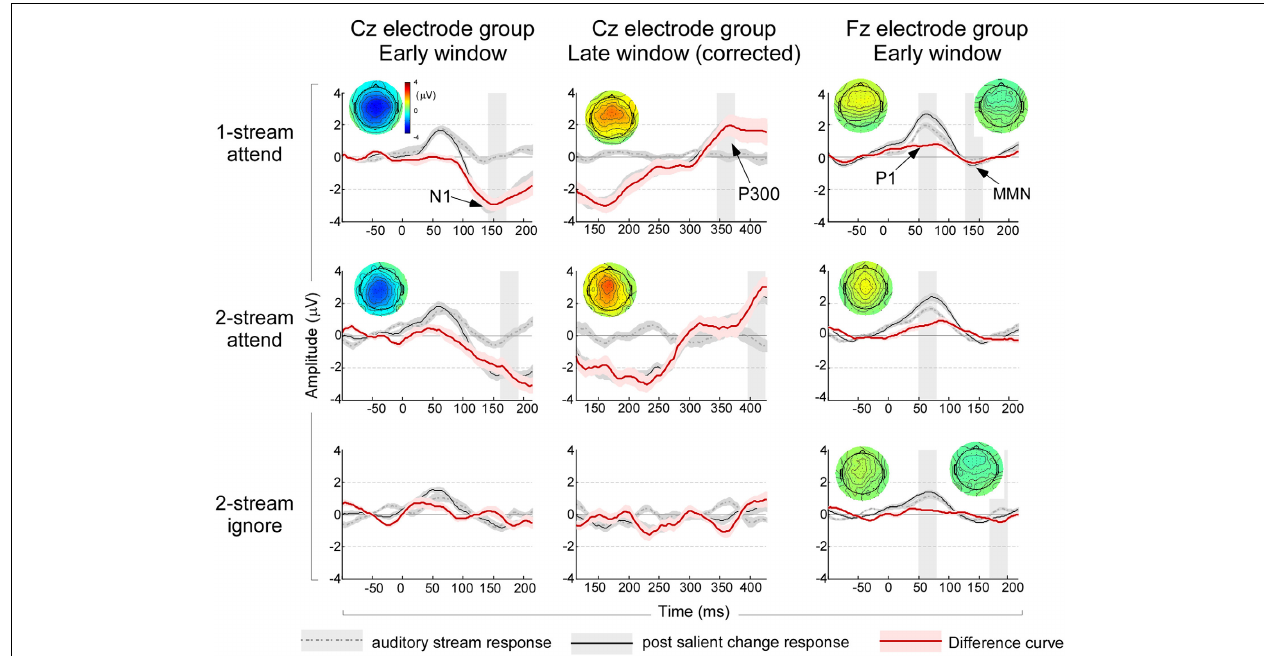
FIGURE 4 | Left column: ERP waveforms and topographies in the early window immediately after onset of the music note from the Cz electrode group. The waveforms are based on analysis of 1-note before (dashed gray line) and 1-note after (solid black line) a salient change, in addition to a difference curve (solid red line). The shaded curves indicate a standard error around the mean waveform. A shaded time interval indicates a 30ms window where a statistically significant N1 peak is observed, along with the full head scalp topography of the N1 peak in the same analysis window. Middle column: ERP waveforms and topographies in the late window after note onset corrected for onset effects of the following note from the Cz electrode group. The analysis follows the same structure shown in the